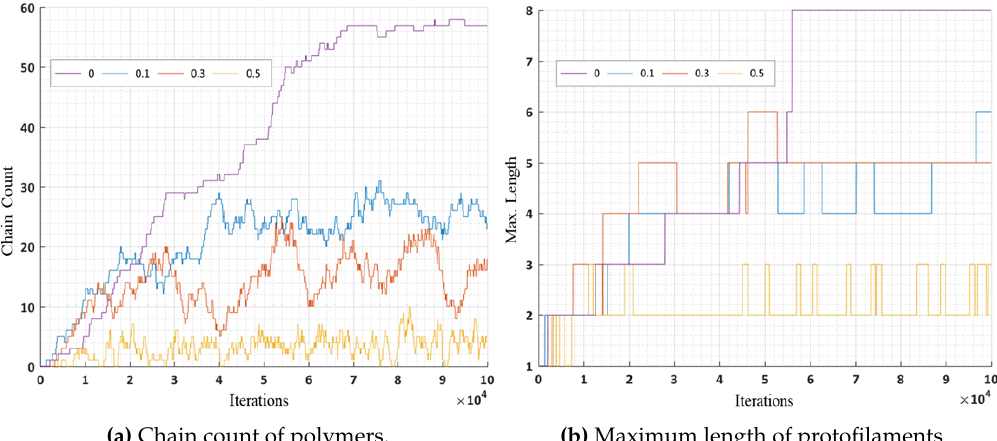
Figure 16. Analysis results of simulation 4, with constant P GTP = 1 and a varying P break over